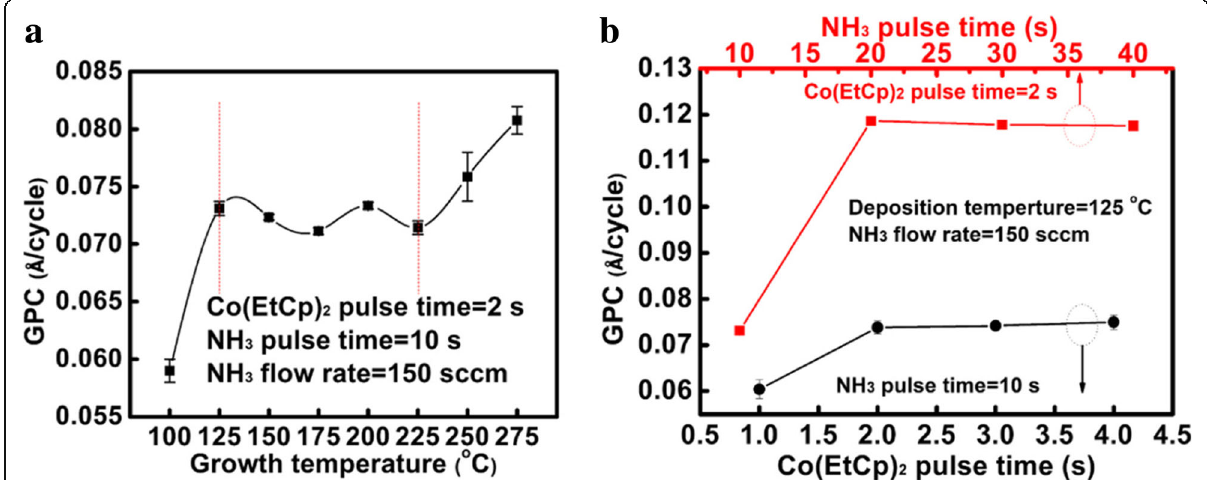
Fig. 1 Dependence of the growth rate of the ALD film on a substrate temperature, b Co(EtCp) 2 , and NH 3 pulse time